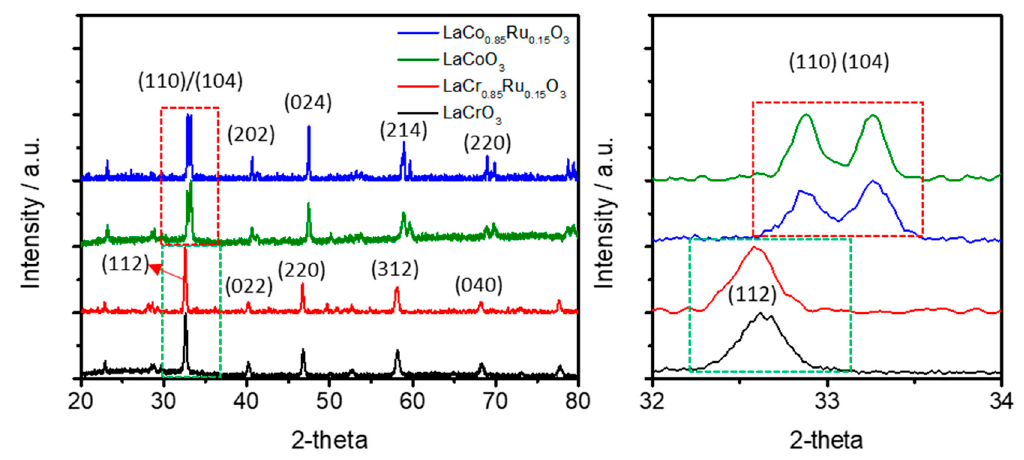
Figure 3. XRD patterns with the magnification of peaks (110)/(104) and (112) (right hand side) of LaCr 0.85 Ru 0.15 O 3 and LaCo 0.85 Ru 0.15 O 3 , including LaCrO 3 and LaCoO 3 as references.